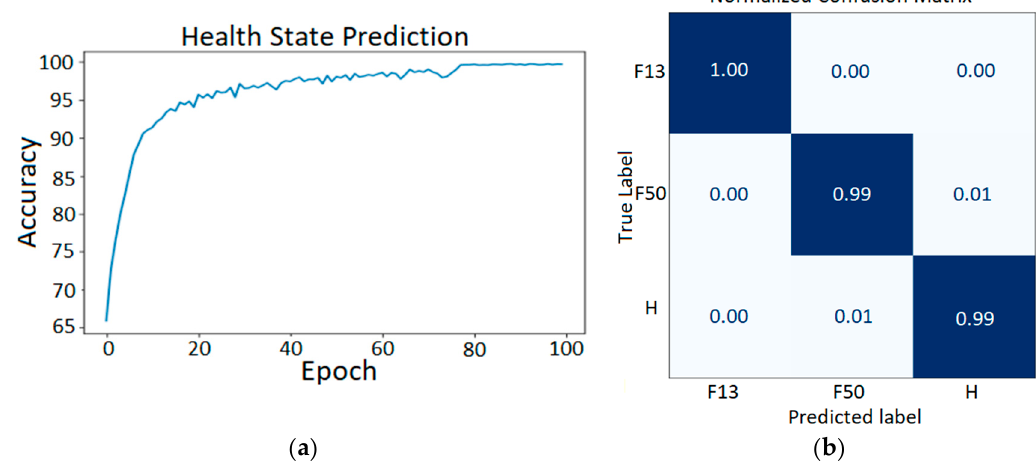
Figure 11. Health State Accuracy prediction as a function of epochs ( a ) and the resulting confusion matrix for the health state prediction model ( b ).